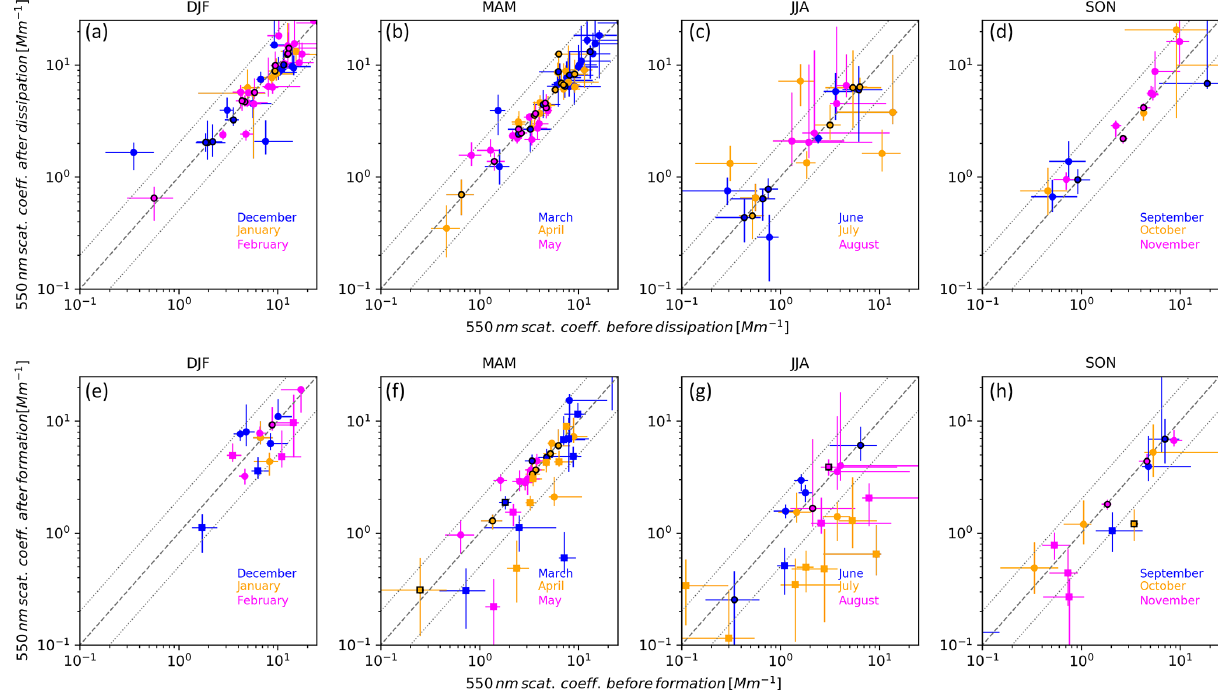
Figure 7. Same as in Fig. 6 but for distributions of 550nm scattering coefficient [Mm − 1